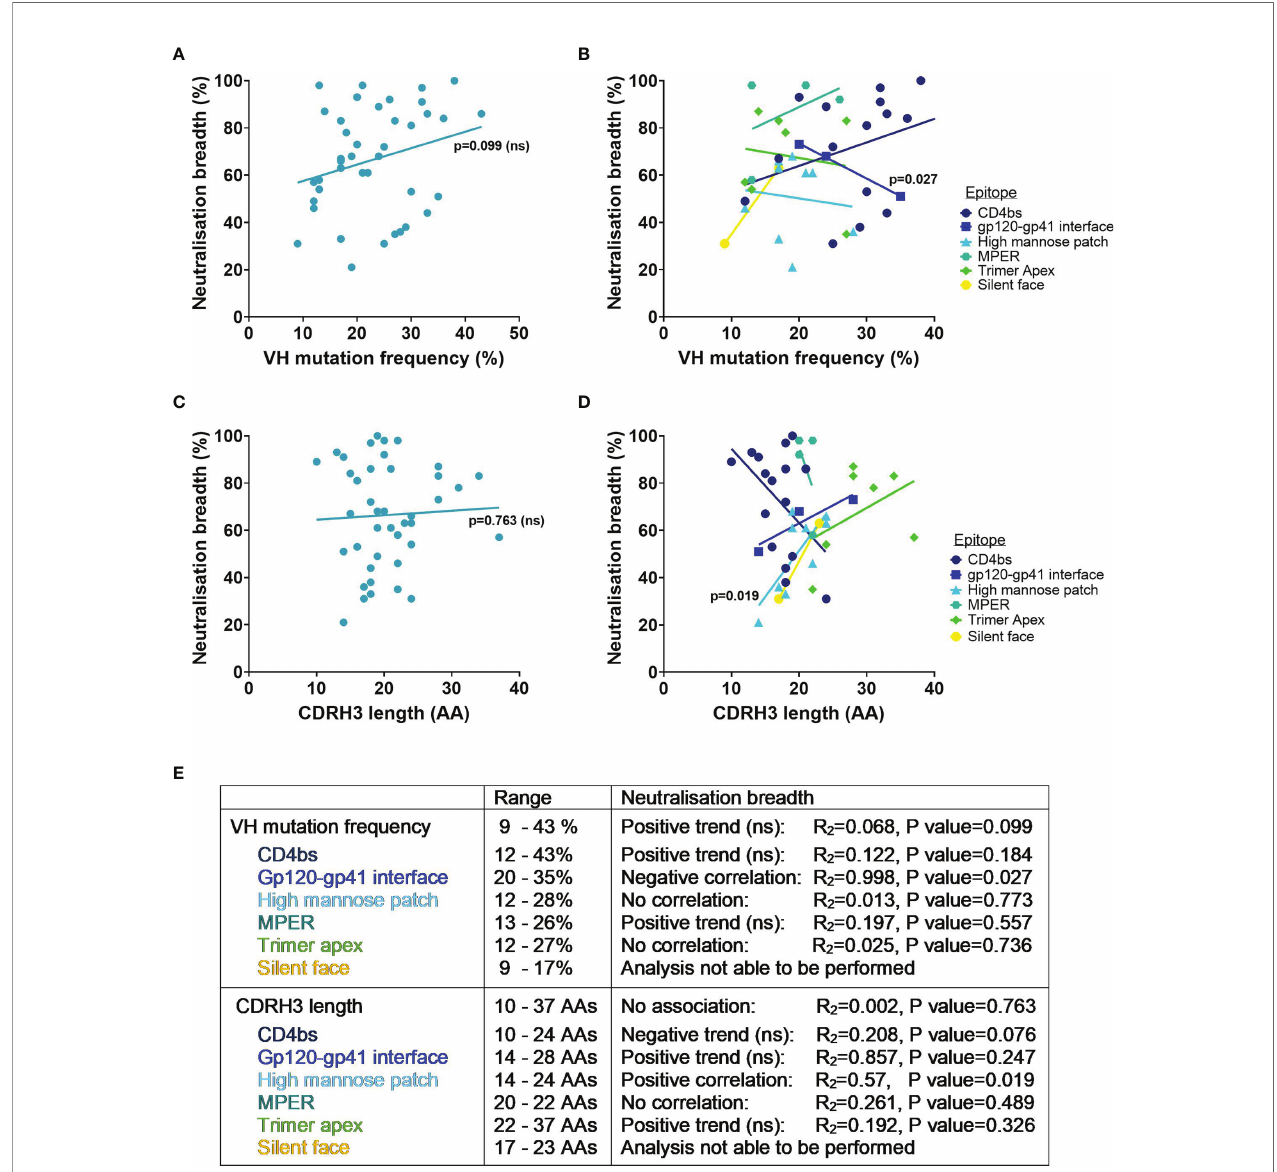
FIGURE 3 | VH mutation frequency, CDRH3 length and neutralisation breadth of HIV bnAbs against the 118 multi-clade PV panel. Mutation frequency was determined from VH nucleotide sequences. Correlations were determined by linear regression analysis, with p <0.05. (A) VH mutation frequency and neutralisation breadth of bnAbs had no association ( p= 0.099). (B) VH mutation frequency and neutralisation breadth of bnAbs grouped by epitope was associated for gp120-gp41 interface bnAbs ( p =0.027). (C) CDRH3 length and neutralisation breadth of bnAbs had no association ( p =0.763). (D) CDRH3 length and neutralisation breadth of bnAbs grouped by epitope was associated for high mannose patch bnAbs ( p =0.019). (E) Summary of VH mutation frequency and CDRH3 length associations with neutralisation breadth. ns, Not signi fi